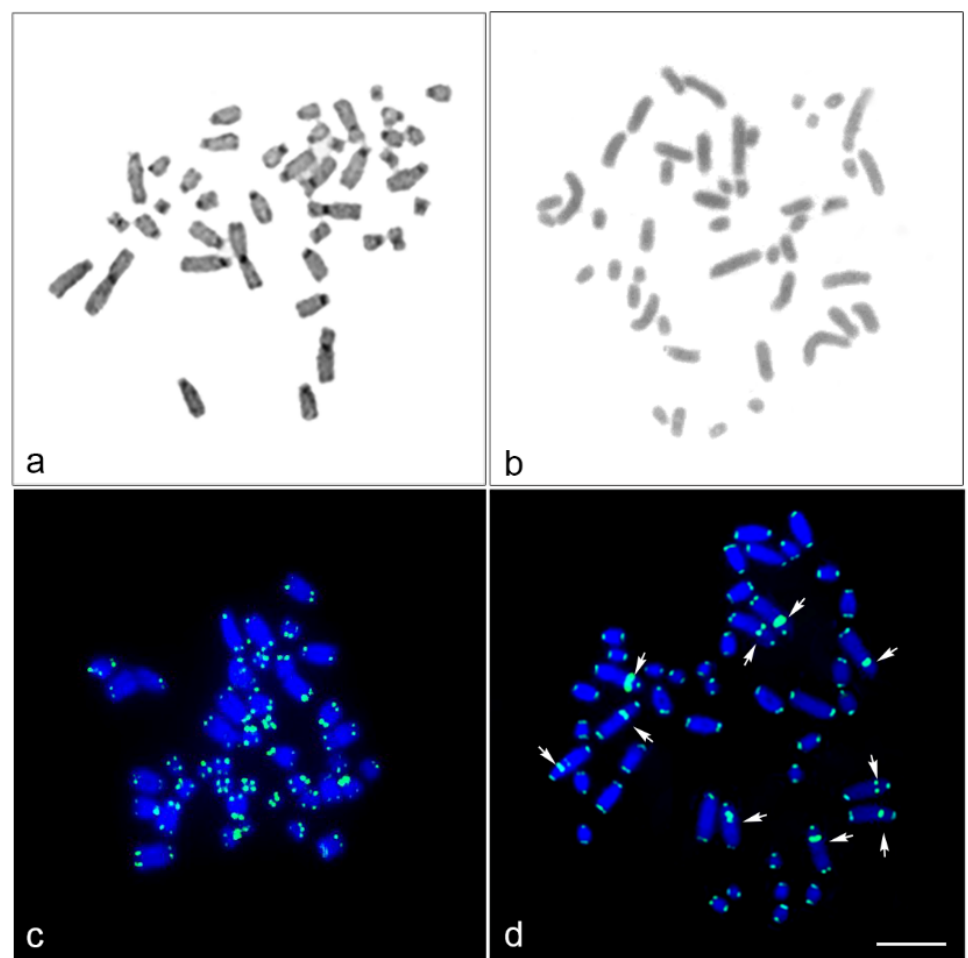
Figure 2. C-banded metaphase spread, and chromosomal locations of the telomeric ( TTAGGG ) n sequence in the common house gecko ( Hemidactylus frenatus , Duméril and Bibron, 1836) [72] and the flat-tailed house gecko ( Hemidactylus platyurus , Schneider, 1797) [73] . C - banded metaphase spread in HFR ( a ) and HPL ( b ) . FISH patterns of the telomeric ( TTAGGG ) n sequence on DAPI - stained metaphase chromosome spreads of HFR ( c ) and HPL ( d ) . Arrows indicate signals of interstitial telomeric sites . Scale bars represent 10 μ m.